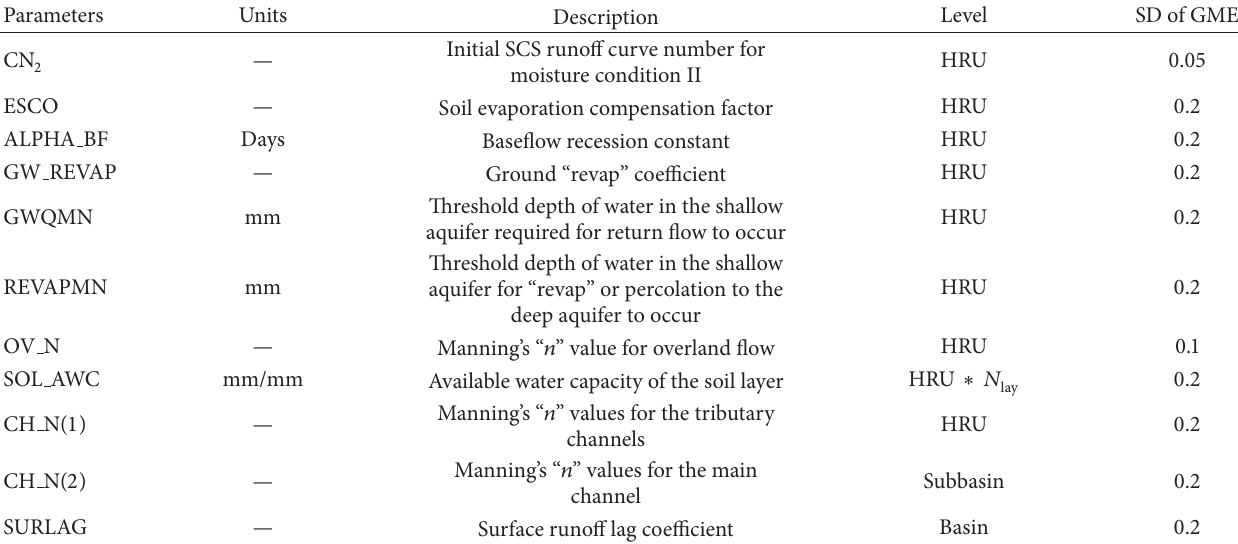
Table 4: The sensitive parameters in SWAT for rainfall-runoff modeling and their standard deviation (SD) of Gaussian multiplicative error in streamflow assimilation.